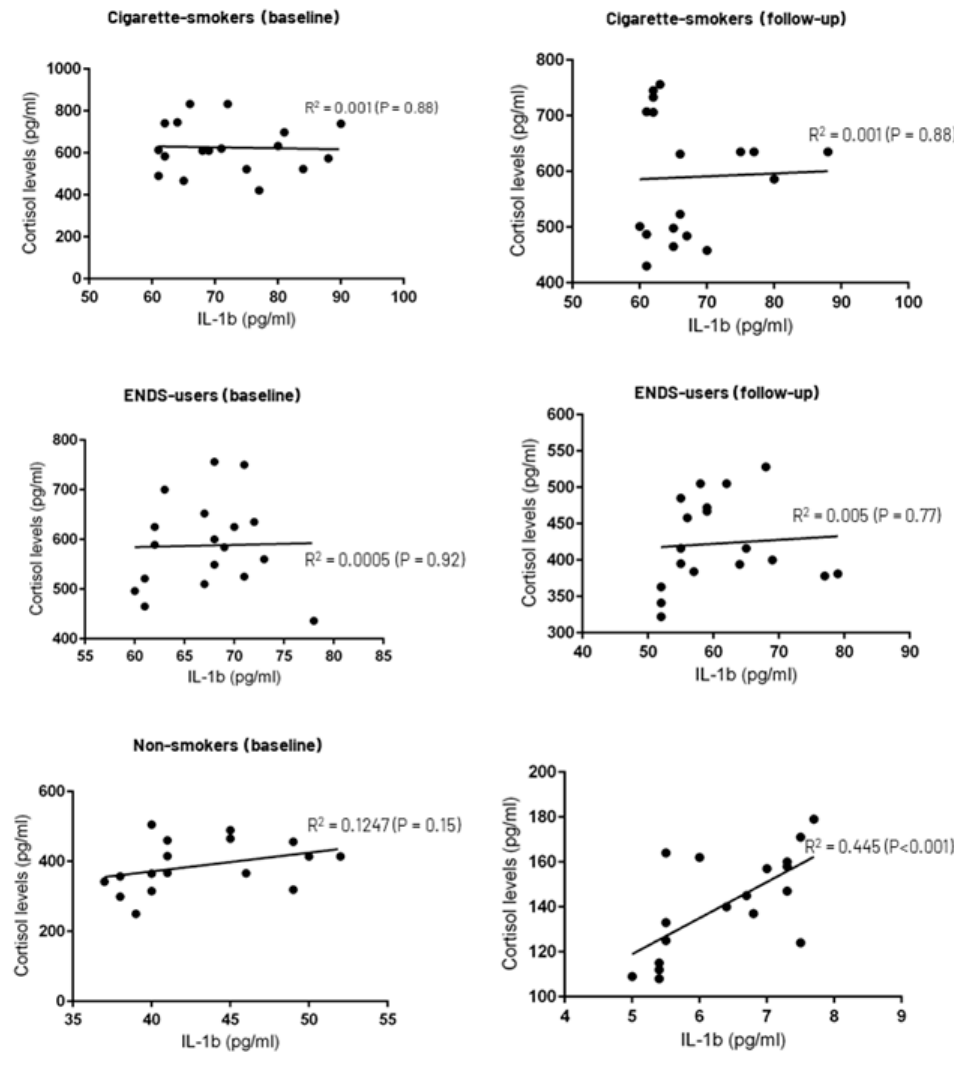
Figure 1. Correlation between whole salivary cortisol and IL-1 β levels.